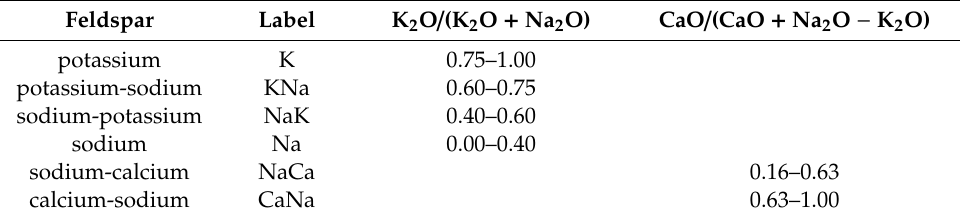
Table 2. Czech classification of feldspars according to the ratio of main oxides. Feldspar